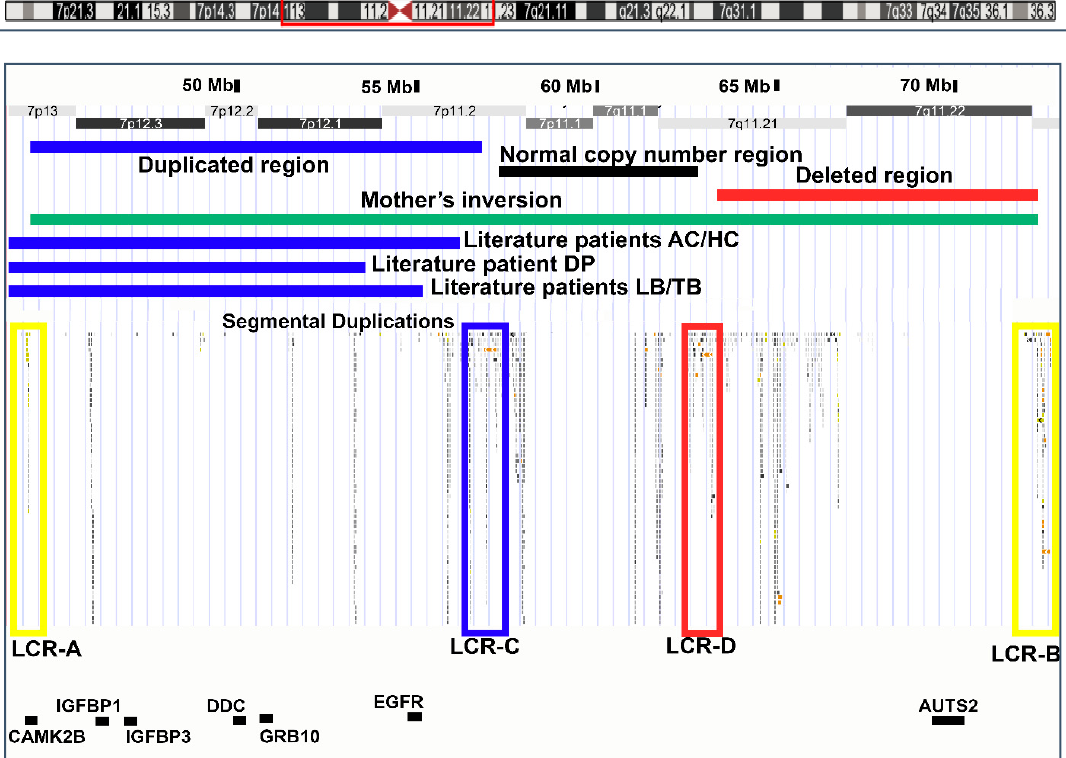
Figure 2. Ideogram of chromosome 7 (top) with the 7p14.1-q11.23 region framed by a red rectangle: and map of this region (UCSC Genome Browser, hg19) (below). Regions involved in the rearrangements in the present case, her mother, and literature cases are shown. Blue bars indicate duplications in the proband and literature cases. The black bar indicates the proband’s normal copy number region. The red bar indicates deletions in the proband. The green bar indicates the inversion in her mother. High homology Low Copy Repeat (LCR) blocks are highlighted as colored empty rectangles. Relevant genes discussed in the present work are presented in black